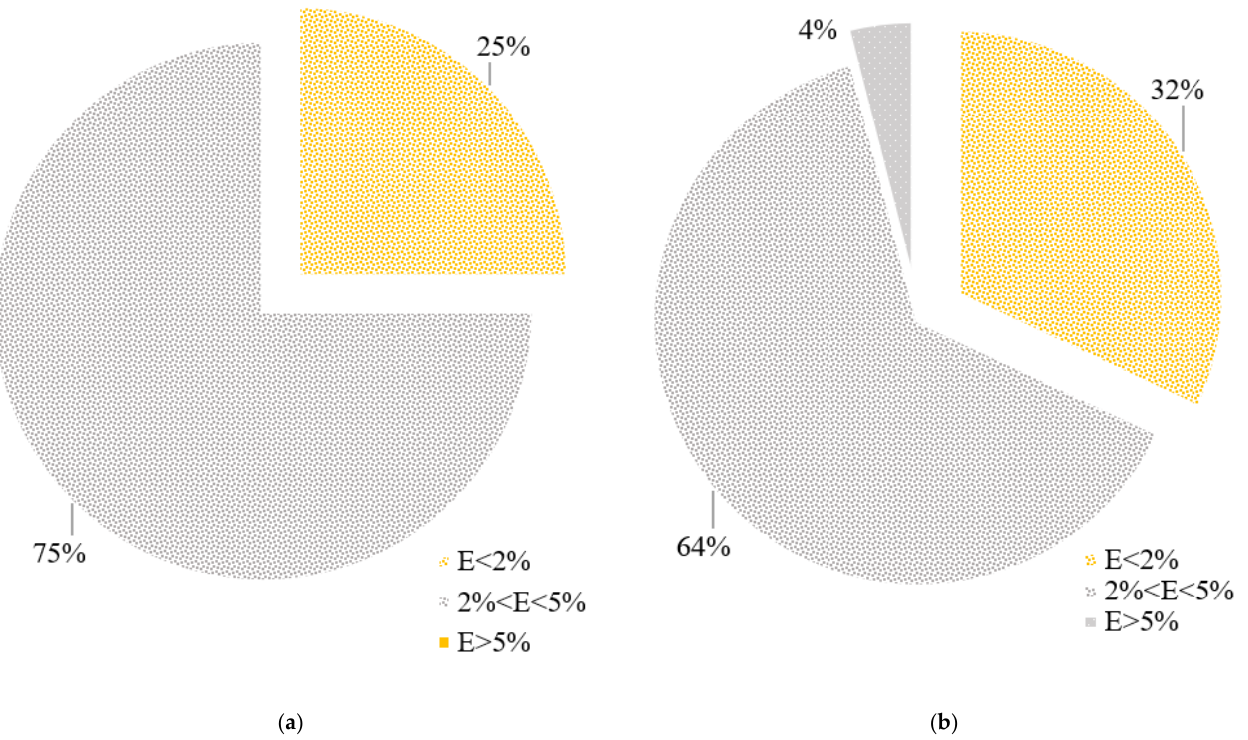
Figure 9. Error distribution of ( a ) SO–SVR and ( b ) SVR on test stage.